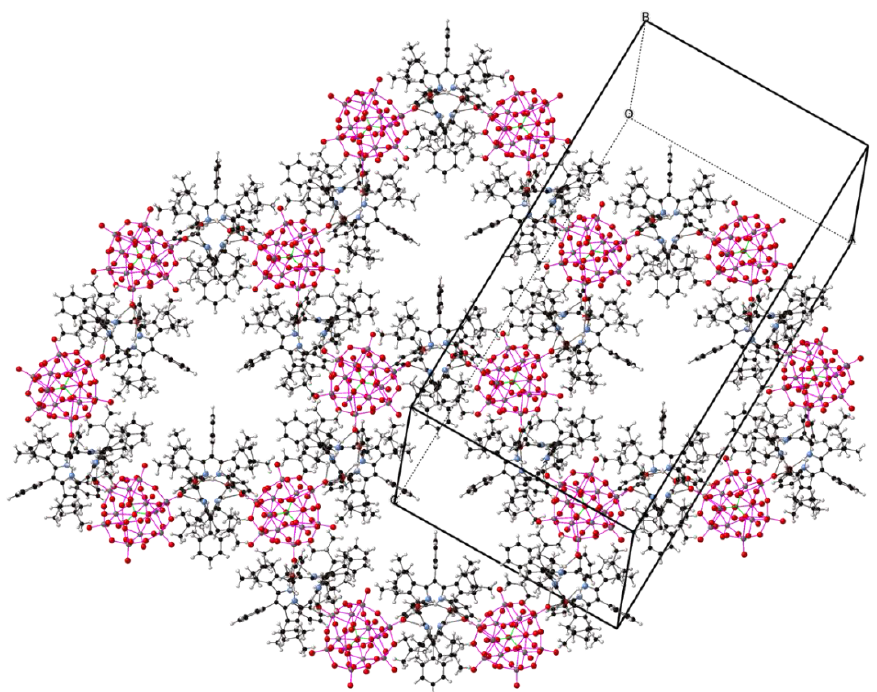
Figure 6. The 6,3-net structure of a single layer of the porphyrin–POM hybrid material [H 4 2 ] 3 (Mo VI 12 O 36 (PO 4 )) 2 · 60(CH 3 OH) · 1.5(H 2 O). The POM components are shown in pink bonds, while atoms are represented as spheres of a fixed radius.